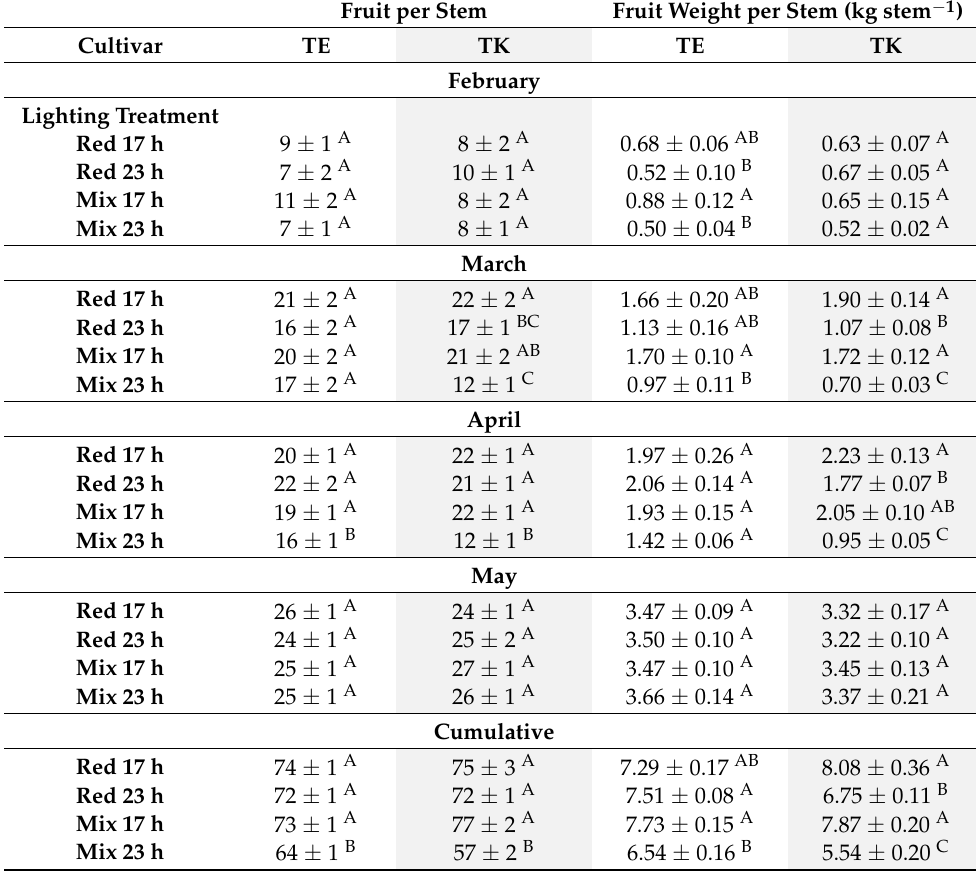
Table 6. Monthly yield analysis for cv. ‘Trovanzo’ grafted onto cv. ‘Emperator’ (TE) or onto cv. ‘Kaiser’ (TK), grown under red 17 h, red 23 h, mix 17 h, and mix 23 h lighting treatments. Values represent the mean ± the standard error of the mean, where n = 4 for TE and TK. TE values are under white columns while TK values are under shaded columns. Of note, values representing May yield include a strip harvest on 22 May 2019. Total yield is the summation of the harvest period. Within each yield parameter, month (or total), and rootstock, letter groups (A, B, C) represent a statistical difference as determined by a two-way ANOVA with a Tukey–Kramer adjustment ( p < 0.05). p values at the bottom of the table are representative of the cumulative data after a two-way ANOVA. Fruit per Stem Fruit Weight per Stem (kg stem − 1 ) Cultivar TE TK TE